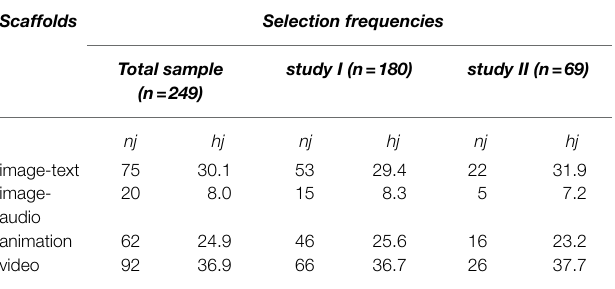
TABLE 12 | Pearson correlation with eye-tracking metrics and cognitive load scales ( n = 69).